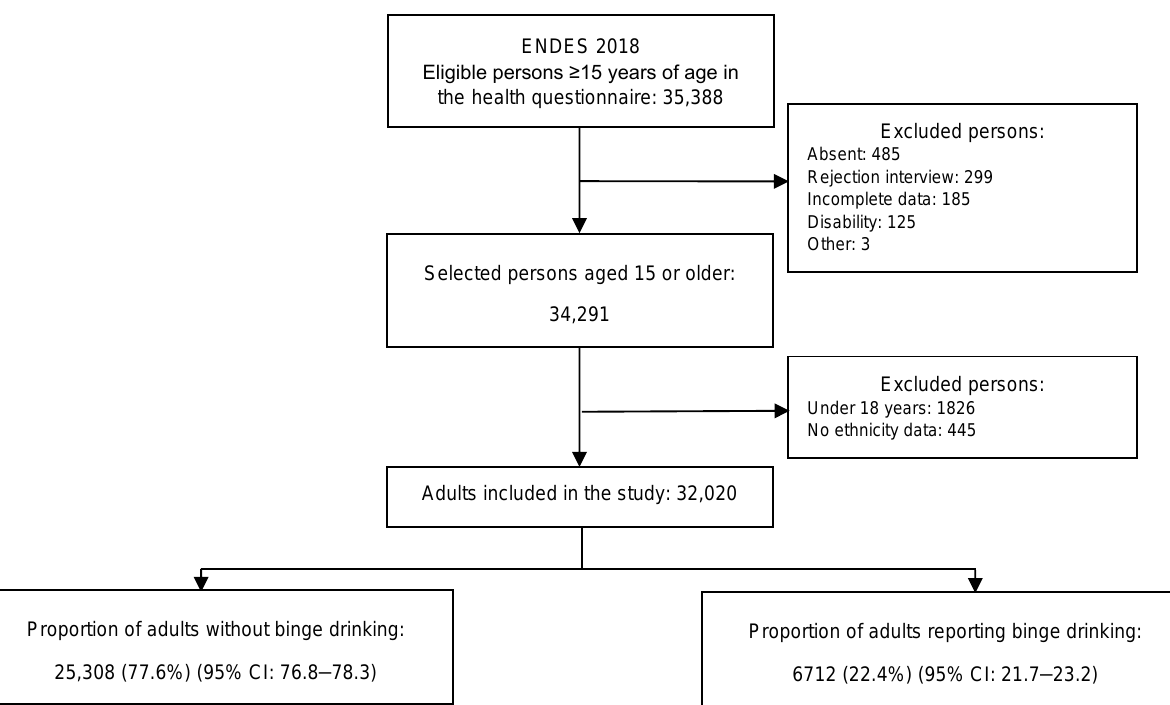
Figure 1. Flowchart of the selection of adults included in the study.